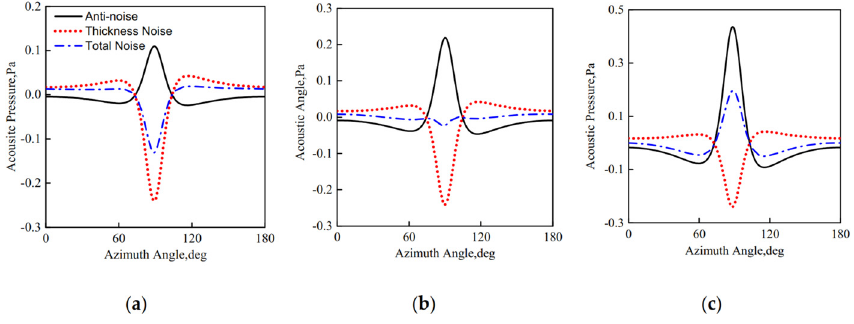
Figure 11. Effect of force amplitude on noise reduction. ( a ) F n = 2 N, ( b ) F n = 4 N, ( c ) F n = 8 N